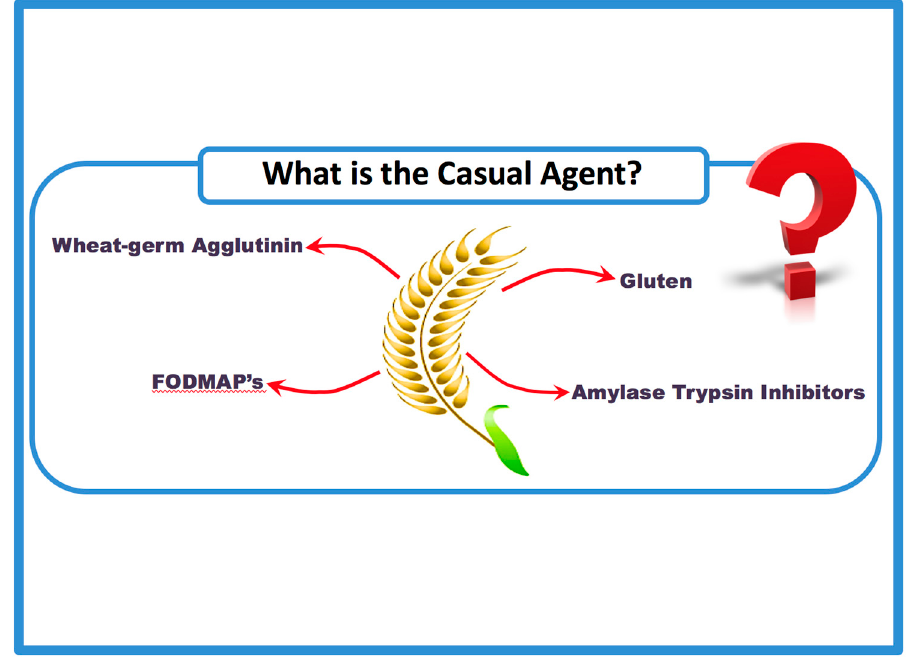
Figure 1. Potential triggers in wheat that may account for both intestinal and extra-intestinal symptoms.